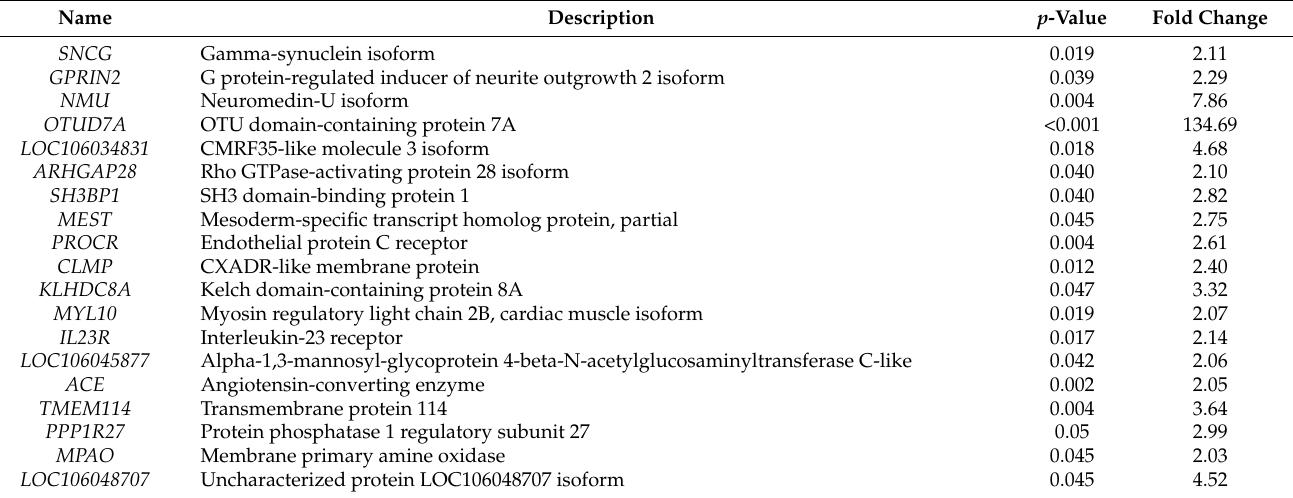
Table 2. The upregulated genes in hepatocytes transfected with pcDNA3.1(+) containing goose OTU deubiquitinase 7A CDS and an empty vector.